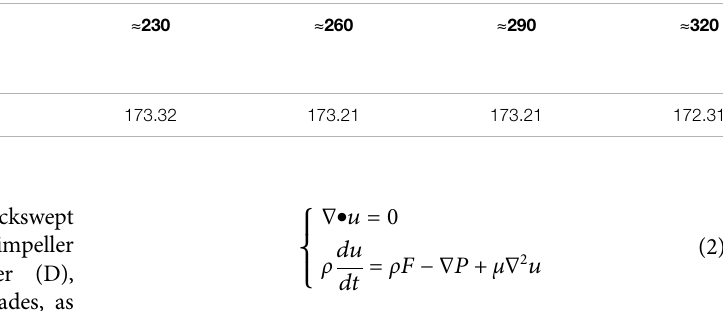
TABLE 2 | Veri fi cation of grid